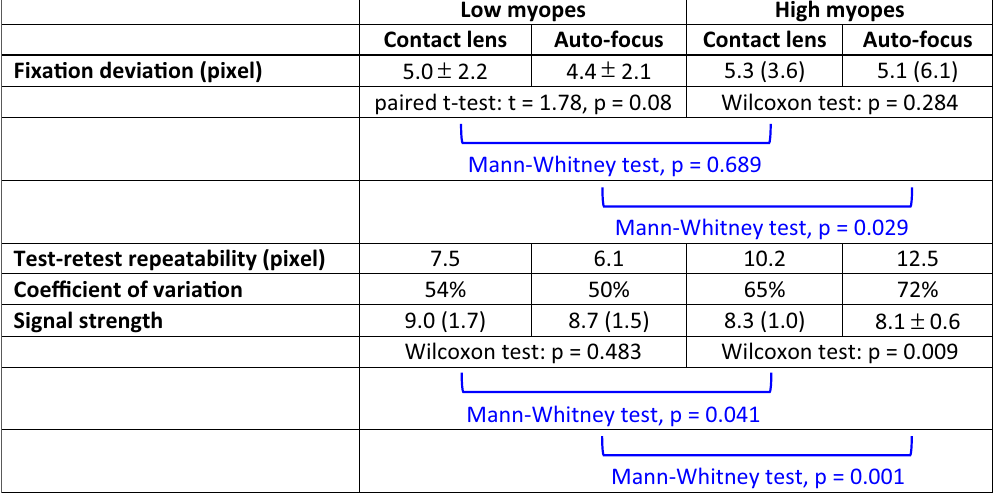
Table 2. Fixation deviation and stability, signal strength and refractive astigmatism of low and high myopic groups. Results are presented as mean ± SD, or median (IQR).